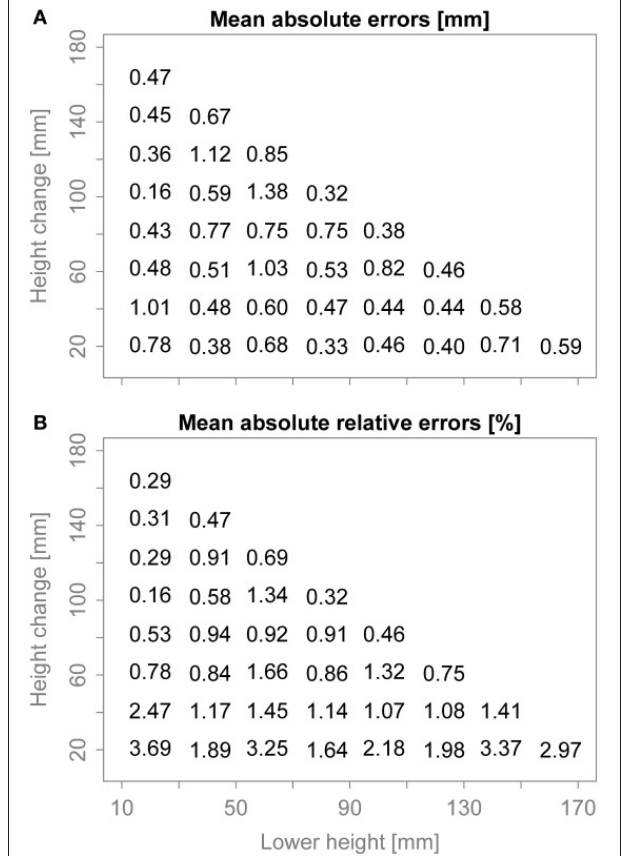
FIGURE 4 | Mean absolute errors (A) and mean absolute relative errors (B) as functions of height change and the height of the bottom surface. Each number is the mean of the errors at the 45 remaining